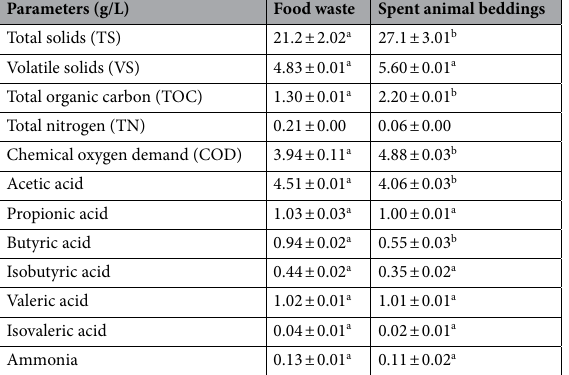
Table 3. Characteristics of fermentation liquid from food waste and spent animal beddings after reconstitution. Values shown in table are means of triplicate analyses with respective standard errors; superscripts with same letters are statistically the same by the Tukey’s test at